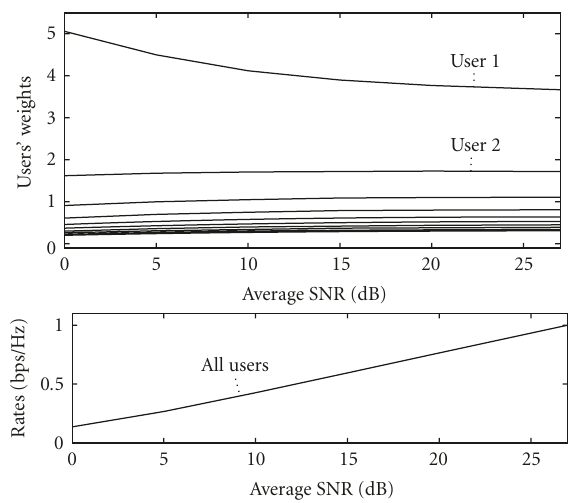
Figure 5: Optimum weight vectors for fair scheduling in the 10- users channel and individual